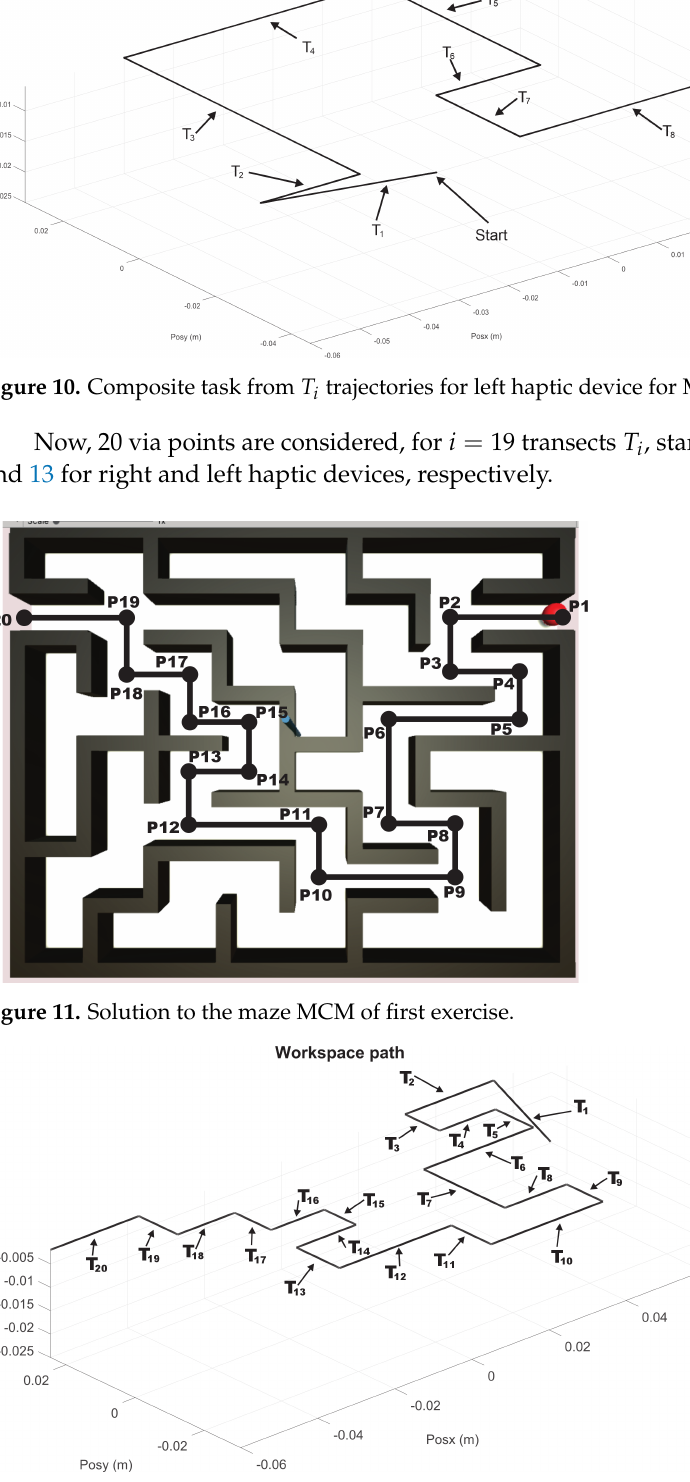
Figure 12. Composite task from T i transects for right haptic device of exercise 2